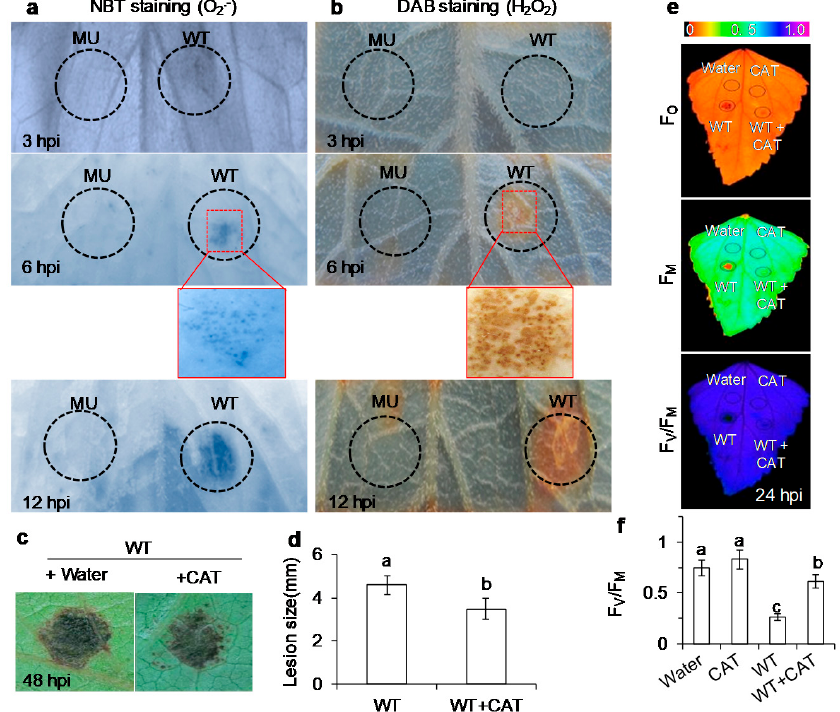
Figure 5. TeA-induced ROS burst is involved in A. adenophora infection by A. alternata . ( a , b ) The accumulation of ROS in A. adenophora leaves inoculated with A. alternata wild-type (20 µ L, WT) and mutant ∆ HP001 (20 µ L, MU) mycelial homogenates for 3, 6, and 12 h. NBT and DAB staining were used to visualize the production of superoxide anion (O 2 •− ) and hydrogen peroxide (H 2 O 2 ). Microscopic observations were made at a 10 × magnification. Experiments were repeated at least three times with similar results. The ROS scavenger catalase reduced A. alternata -caused necrotic lesions ( c ) and their average diameter ( d ) and photosynthetic damage ( e , f ) on A. adenophora leaves. A. adenophora leaves pretreated with 300 U mL − 1 catalase or sterile water were inoculated with A. alternata wild-type mycelial homogenates (20 µ L) or without A. alternata for 24 or 48 h, and then chlorophyll fluorescence imaging and leaf lesions were measured. Fluorescence images were indicated by a color code in the order of black (0) through red, orange, yellow, green, blue, violet to purple (1). Images of F O (minimal fluorescence), F M (maximal fluorescence), and F V /F M (the maximum quantum yield of PSII) ( e ) and the values of F V /F M ( f ) were shown. Black open circles on leaf images indicate the primary inoculation sites. Data shown are mean values ± SD of three independent biological replicates. The different small letters above the error bar mean a significant difference at 0.05 level. CAT: